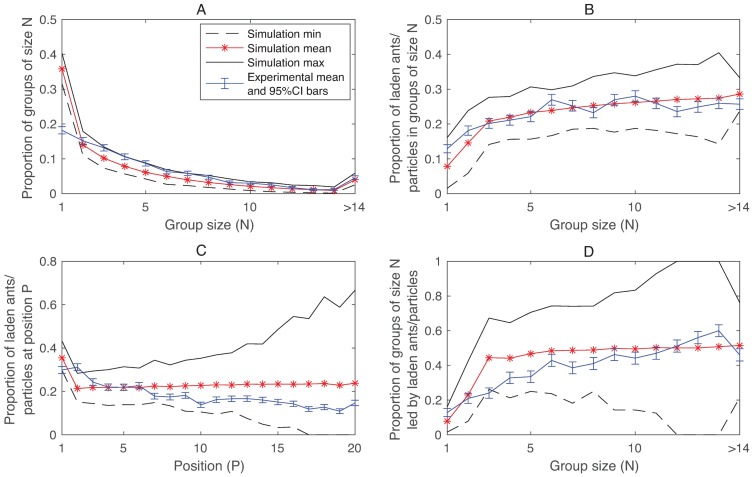
Comparison model-experiment for the narrow trail.In each plot the blue curves represent the experimental means and the values correspond to those presented in Figs 2–5 in [22]. The red asterisks represent the simulation means and the black lines represent the maximum and the minimum over 1000 simulations.